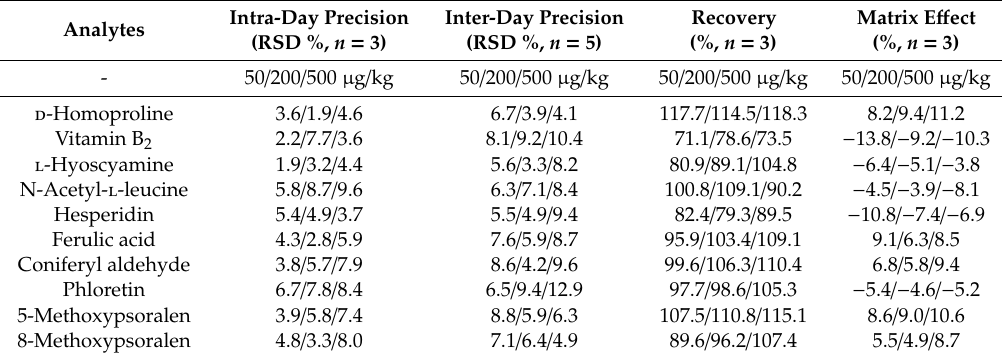
Table 3. Intra-day precisions, inter-day precisions, matrix effects and recoveries of 10 nutritional